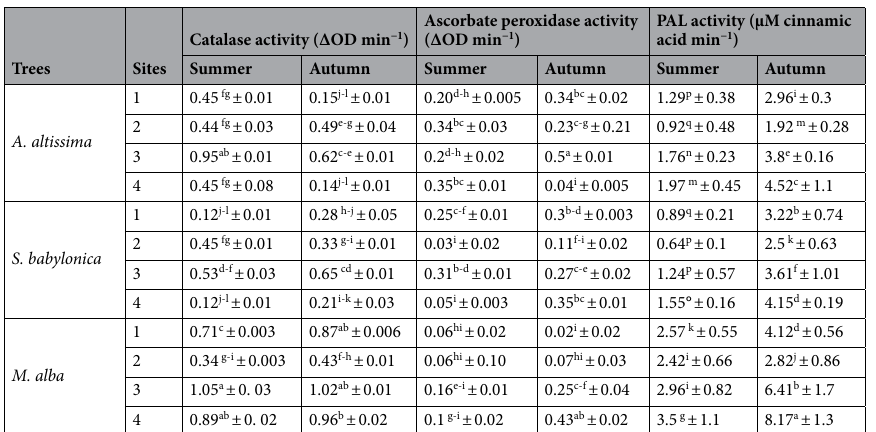
Table 3. Comparing the effect of air pollution stress on the catalase, ascorbate peroxidase and PAL activities of A. altissima , S. babylonica , and M. alba trees. Two seasons of Summer and Autumn at Sites 1 (Mirdamad Street), 2 (Mirza Babaei Street), 3 (Kargar Shomali Street), and 4 (Azadi Bus Station Street) Tehran. The means that have at least one common letter did not show a statistically significant difference ( P < 0.05). Data are presented as mean ± SE. PAL phenyalanine amonia